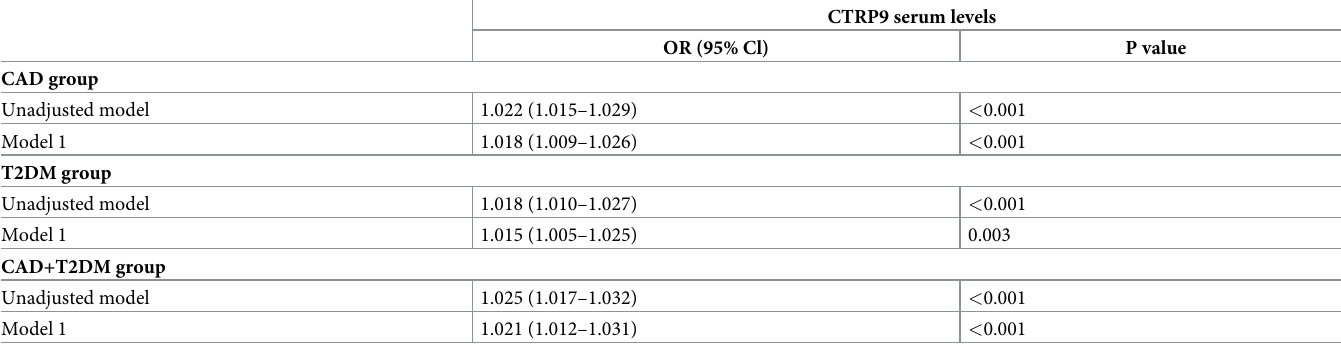
Fig 1. Serum levels of CTRP9 in control, CAD, T2DM and CAD+T2DM category. a) Serum CTRP9 levels were lower in controls (148.7 ± 4.0) than CAD (202.0 ± 4.9), T2DM (191.4 ± 10.1) and CAD+T2DM (211.2 ± 6.8). (all, p < 0.001). b) Serum concentration of CTRP9 was higher in women (208.8 ± 6.2) compared to men (181.8 ± 3.7) (p < 0.001). https://doi.org/10.1371/journal.pone.0192159.g001 Circulating levels of adiponectin were lower in CAD (8.51 ± 0.24) and CAD+T2DM (9.17 ± 0.33) than in the control category (11.36 ± 0.42; p < 0.001; Fig 2A). Serum IL-6 was higher in concentration in CAD (8.5 ± 0.3), T2DM (8.3 ± 0.6) and CAD+T2DM (9.5 ± 0.4) than in the controls (5.3 ± 0.2; p < 0.001; Fig 2B). Circulating levels of TNF- α were lower in control subjects (20.82 ± 0.87) than in those with CAD (27.74 ± 0.54), T2DM (26.65 ± 01.32) and CAD+T2DM (29.12 ± 0.94) (p < 0.001, p < 0.01 and p < 0.001, respectively; Fig 2C). Serum sE-Selectin levels were also higher in CAD (66.9 ± 1.3), T2DM (68.0 ± 2.3) and CAD +T2DM (66.5 ± 1.9) patients compared to normal participants (44.9 ± 1.2; p < 0.001; Fig 2D). Compared with the CAD (311.5 ± 6.4), T2DM (268.0 ± 13.1) and CAD+T2DM (324.9 ±9.9) groups, a lower concentration of serum sICAM-1 was observed in the controls (210.7 ± 6.9; p < 0.001). Serum sICAM-1 was higher in the CAD+T2DM and CAD groups than in subjects with T2DM (p < 0.01 and p < 0.05, respectively; Fig 2E). Compared to normal subjects Table 2. Odds ratios for development of CAD, T2DM and CAD+T2DM based on serumCTRP9